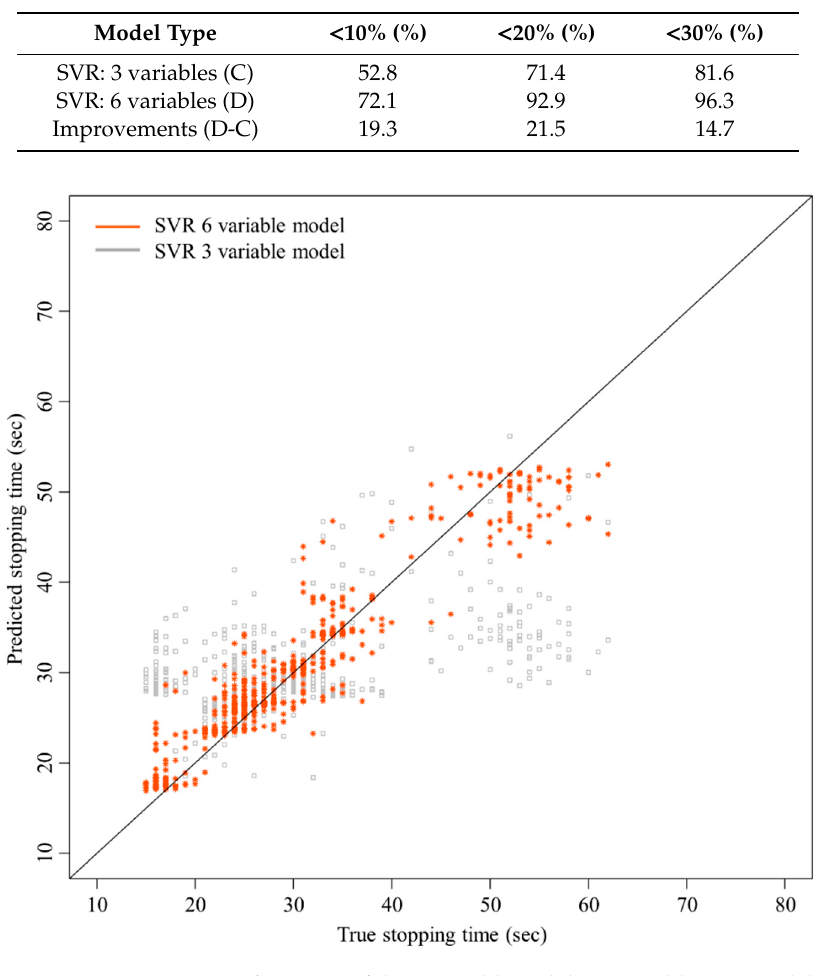
Figure 10. Estimation performance of the 6-variable and the 3-variable SVR model.